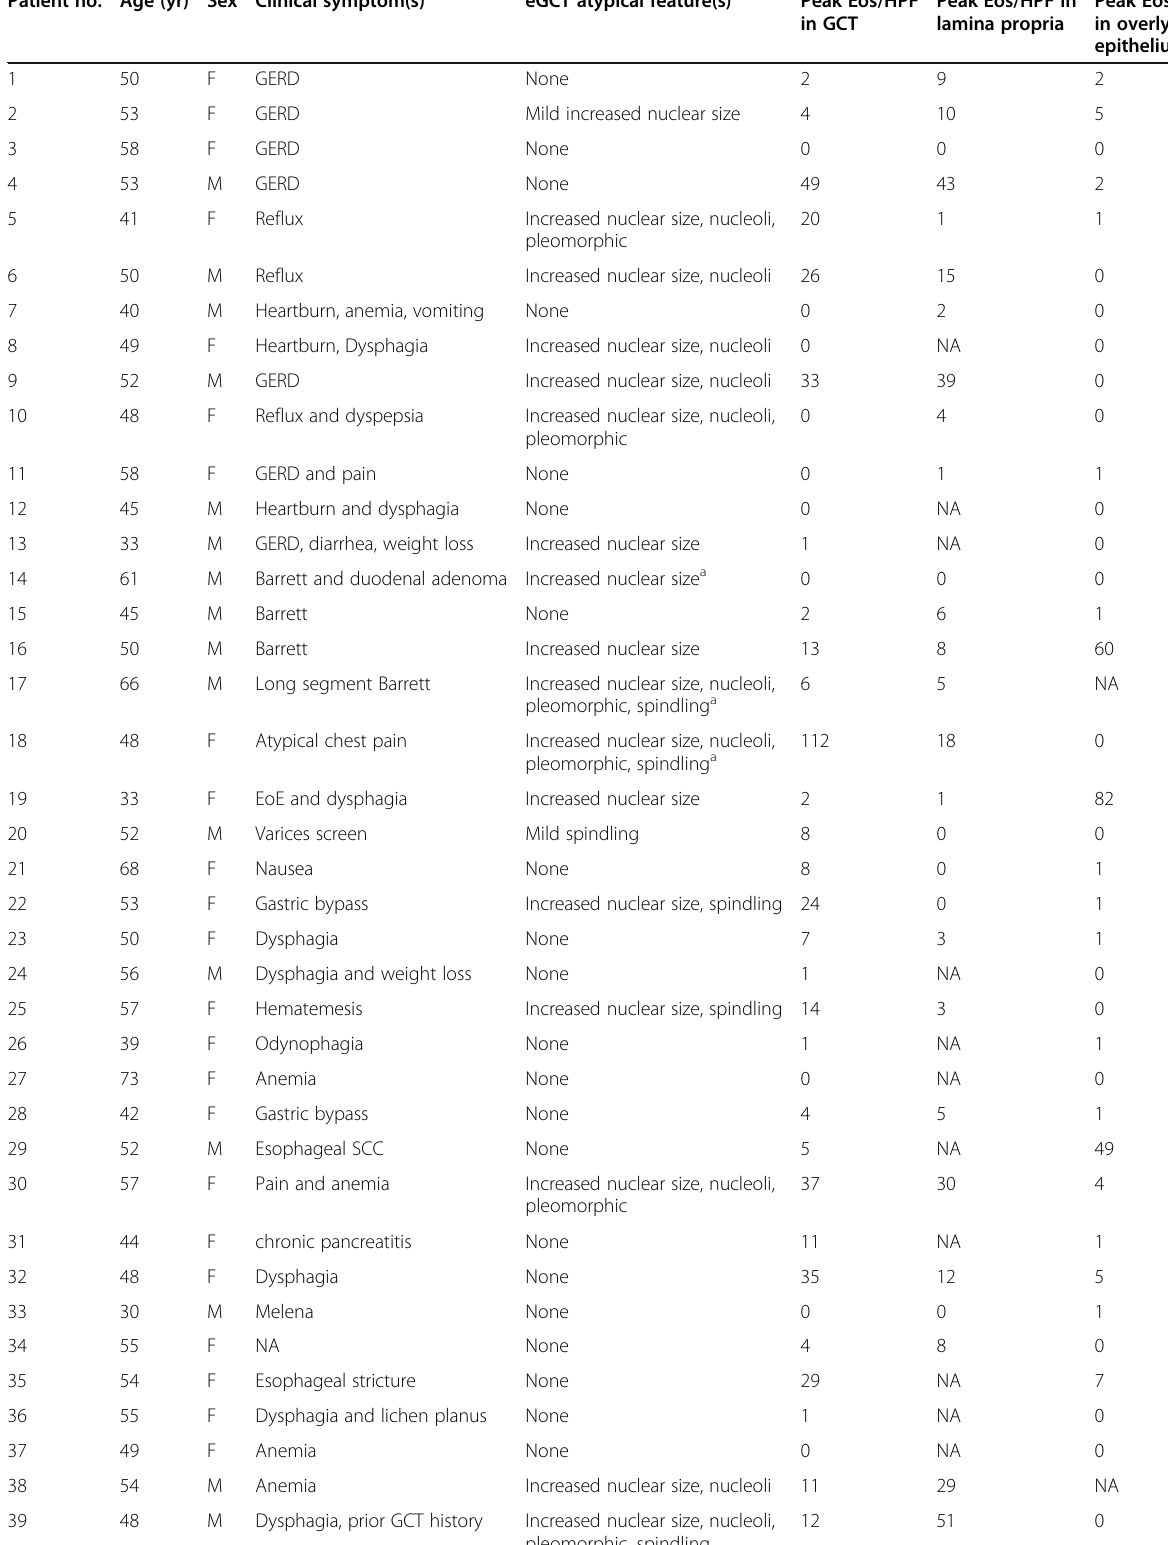
Table 1 Clinical and histologic findings of 45 patients with esophageal granular cell tumor Patient no. Age (yr) Sex Clinical